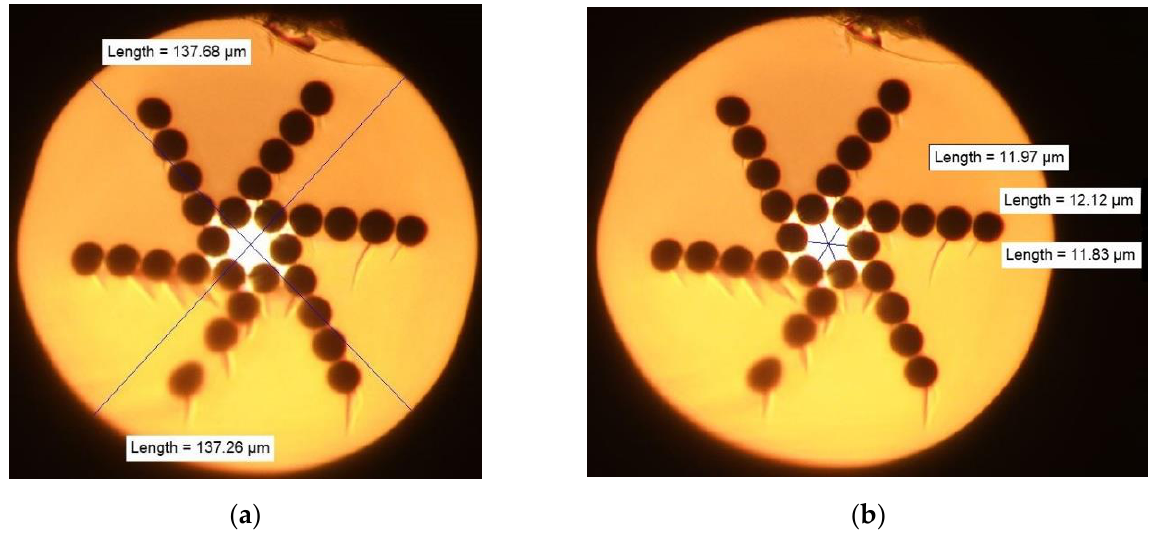
Figure 7. Overall dimensions of manufactured ESSR-MOF sample with chirality of 66 revolutions per meter: ( a ) outer diameter; ( b ) core diameter.